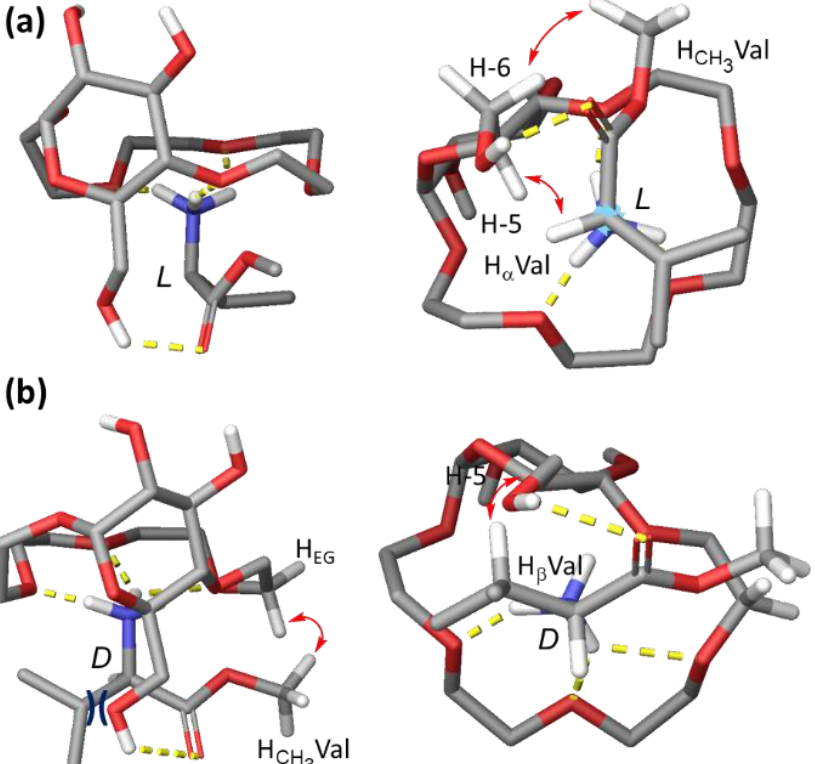
Figure 6. Models of the complexes between 1 and H- L -Val-OMe ( a ) H- D -Val-OMe ( b )—side view (left), bottom view (right). Models were obtained by manual adjustment of the calculated lowest energy conformers after sampling of the non-covalent interactions with MacroModel (NOEs observed in the NOESY spectra marked with red arrows, H-bonds marked in yellow, steric repulsion indicated in dark blue).